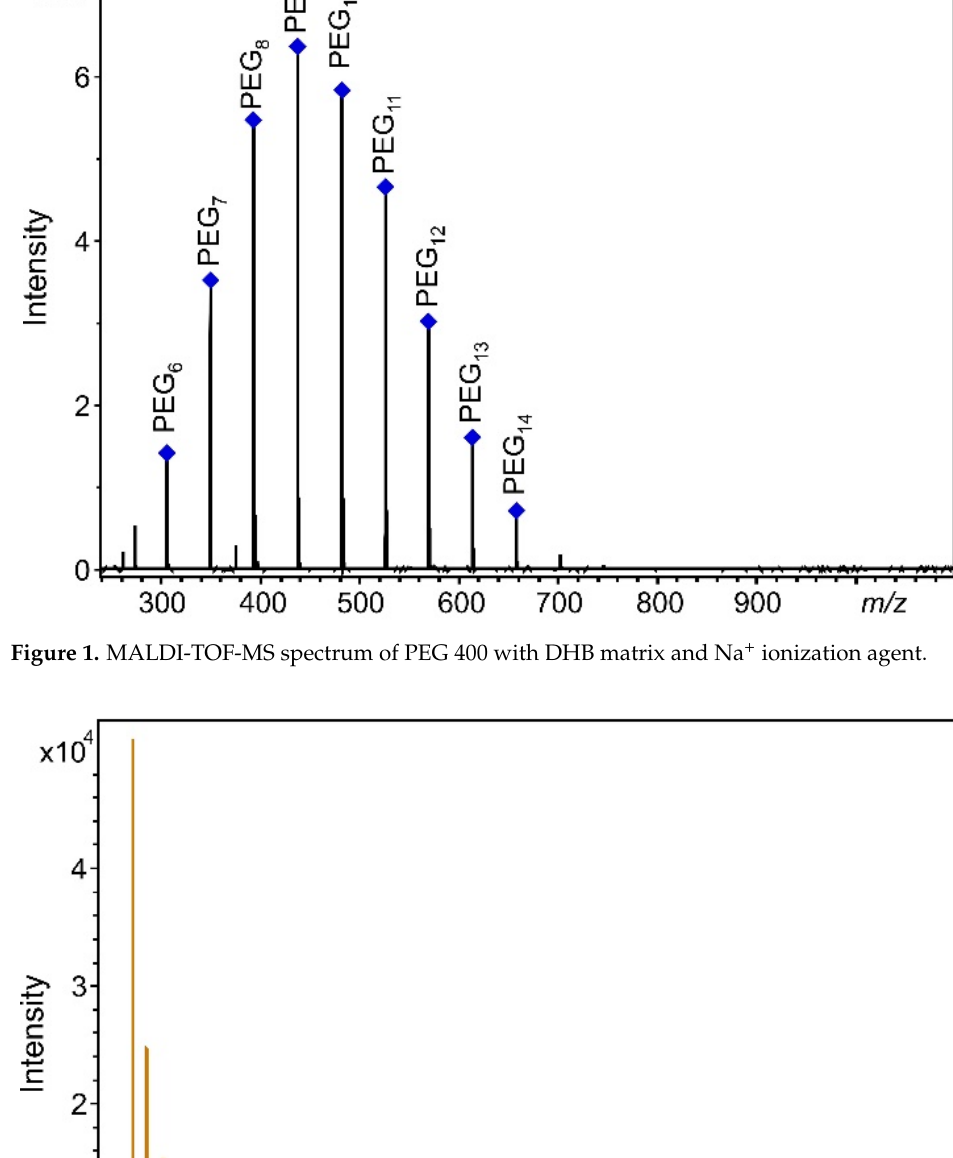
Figure 2. MALDI-TOF mass spectrum of a pre-dose human urine sample.